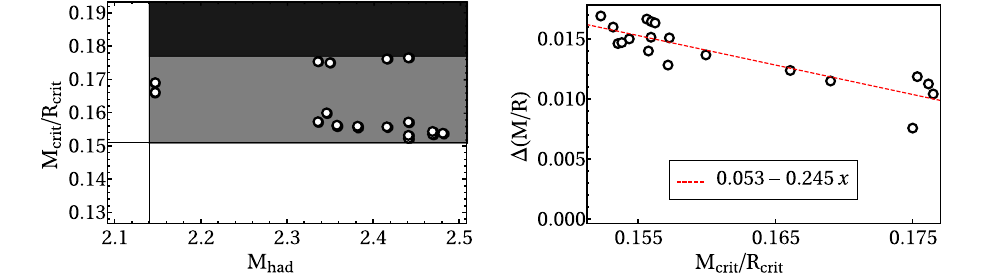
Fig. 8 (Leftpanel)Figureshowstheratioof M crit / R crit asafunctionof M had and the corresponding band of critical compactness (gray region), the unstable region (black region) and the stable region (white region).